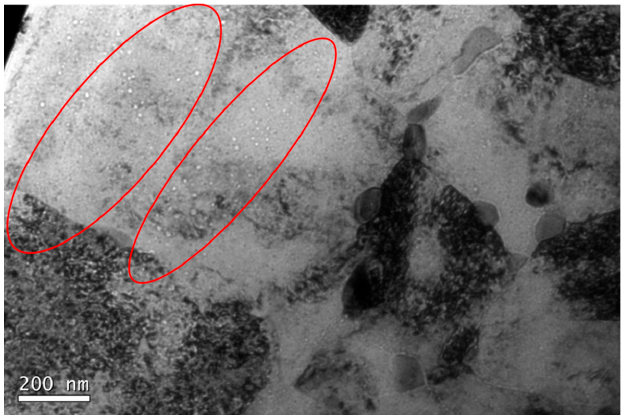
Figure 9. A representative TEM Micrograph of zone A (716 to 657 appm He) of EU-ODS EUROFER steel annealed at 450 °C for 100 h. Highlighted in red the areas of higher cavity density.